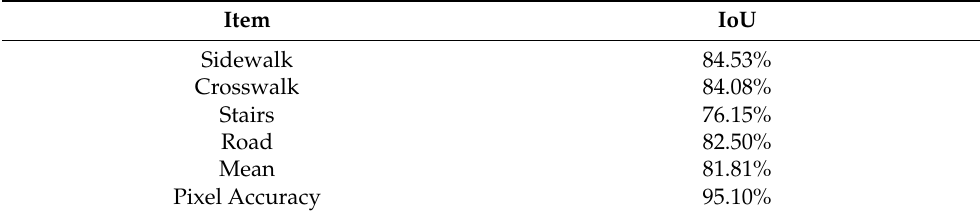
Table 3. The performance of FAST-SCNN.